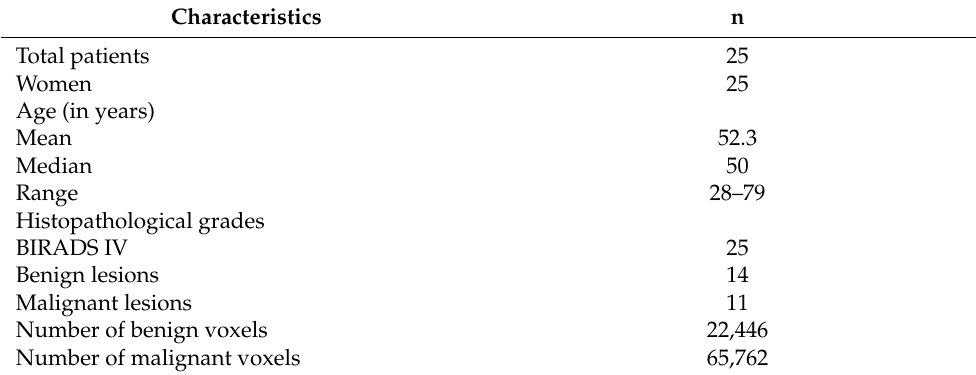
Table 1. Patient